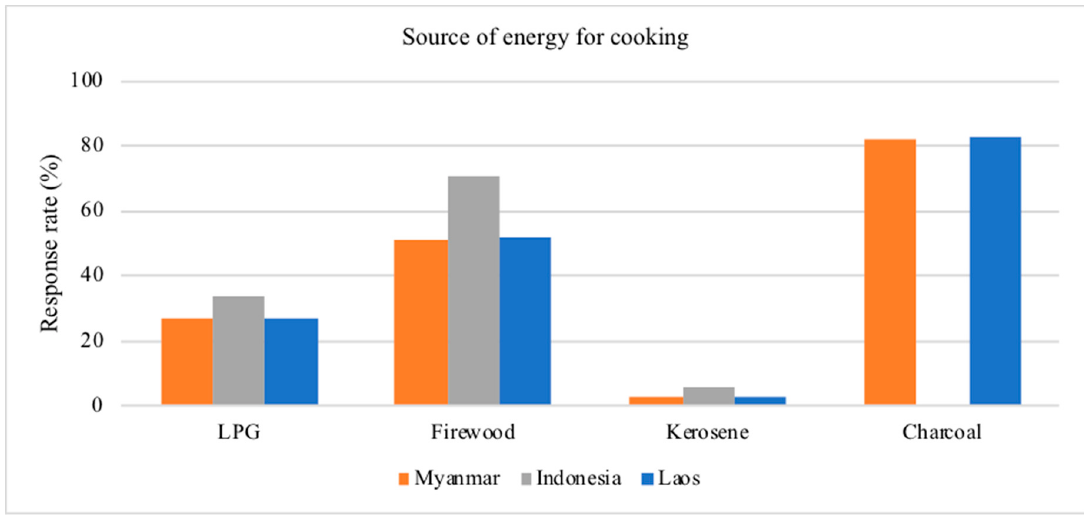
Figure 4. Source of cooking fuel in the three case study villages.